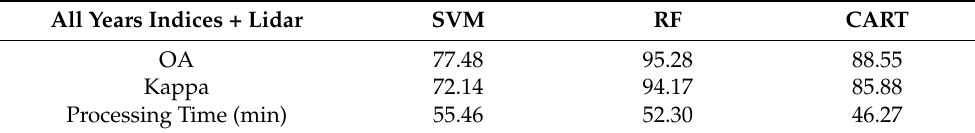
Table 2. SVM, RF and CART Classifier Overall Accuracy, kappa and processing time in minutes.